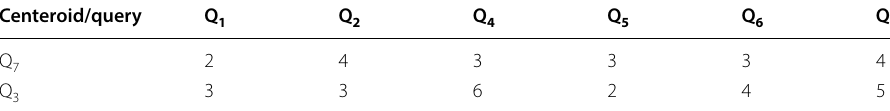
Table 8 Second loop Centeroid/query